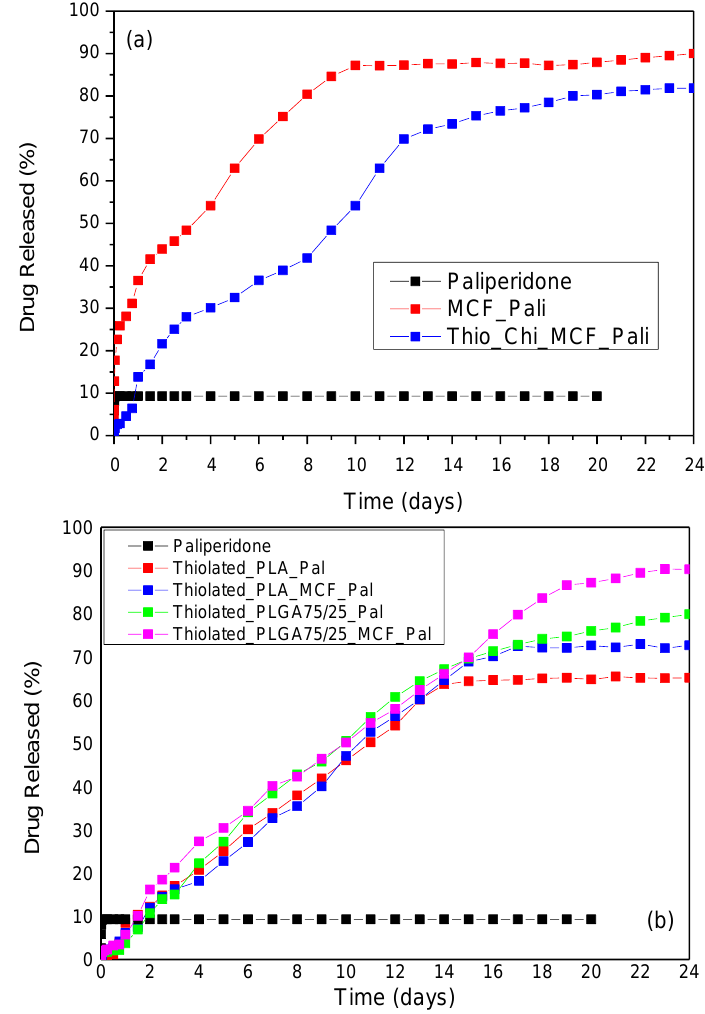
Figure 10. Dissolution profile of a) Thiolated_ MCF_paliperidone and b) Thiolated microspheres.